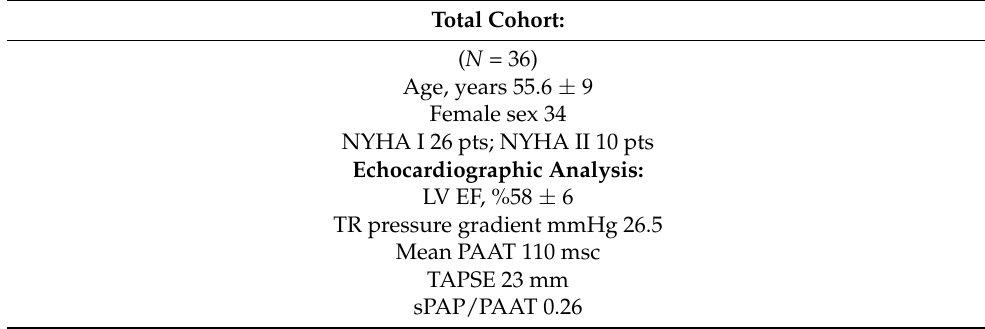
Table 1. Baseline demographic, clinical, and hemodynamic characteristics of patients with sclero- derma without pulmonary hypertension.